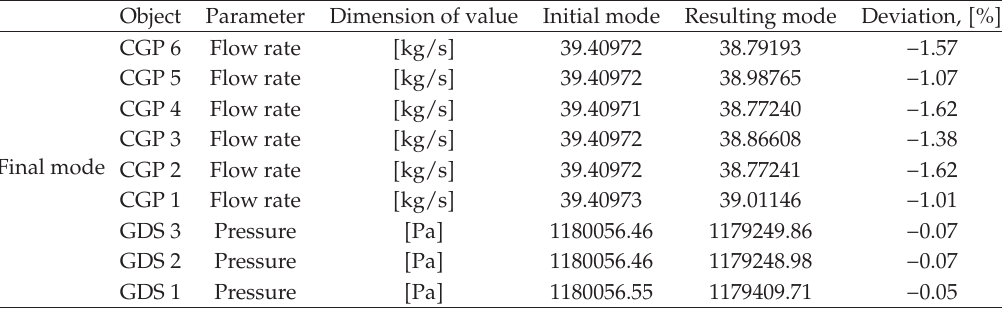
Table 11: The results after Stage 3 of the test simulation.